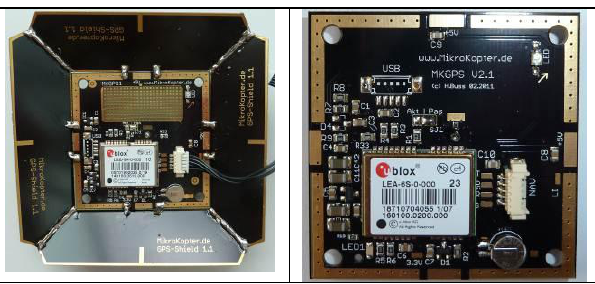
Figure 4. u-blox receivers as part of the GPS circuit board. Left: board surrounded by a protection shield to enhance GPS signal Figure 5. GPS measurements at ground control